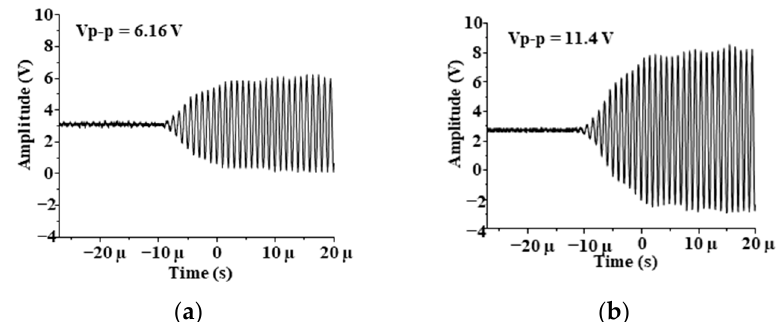
Figure 8. Echo images drawn by computer: ( a ) For water; ( b ) For air.